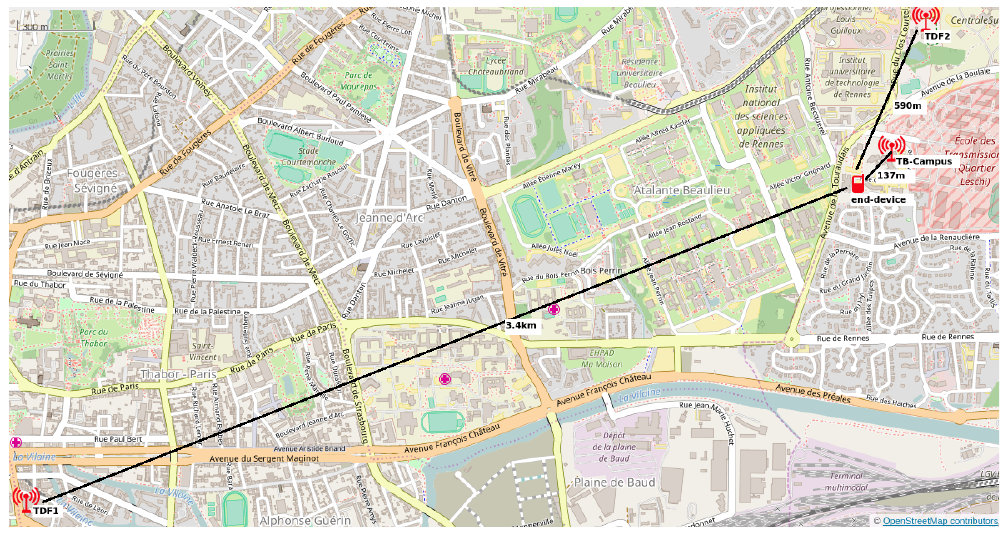
Figure 9. LoRaFabian network in Rennes,